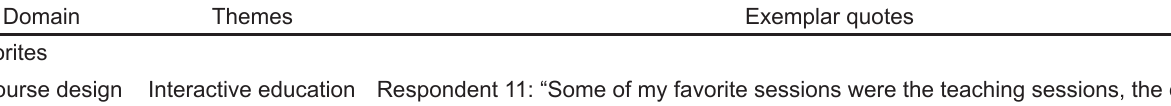
Table 3. Themes identified from the end-of-rotation